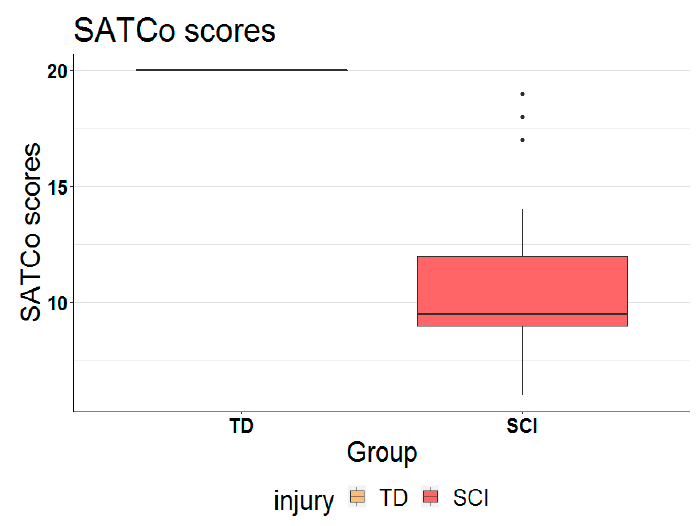
Figure 1. Comparison of Segmental assessment of trunk control (SATCo) scores between typically developing (TD) children and children with spinal cord injury (SCI). Note: every participant in the